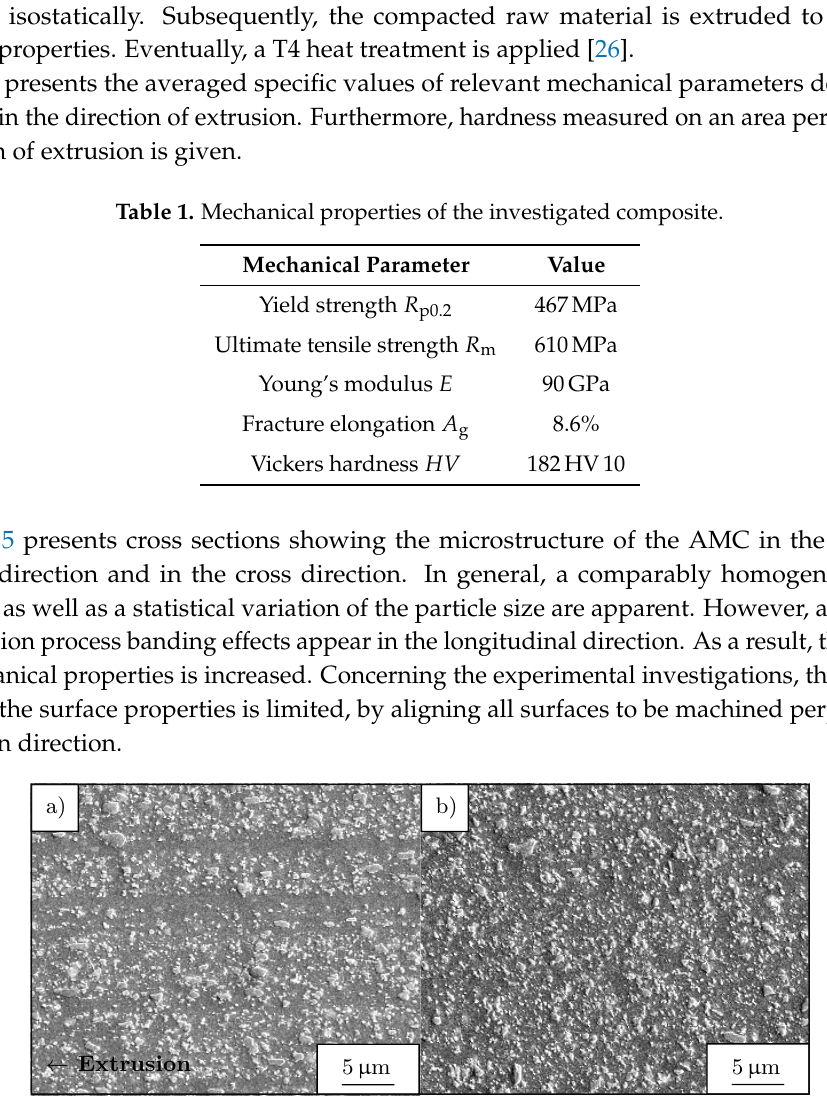
Figure 5. Cross sections of the AMC ( a ) In the longitudinal direction and ( b ) In the cross